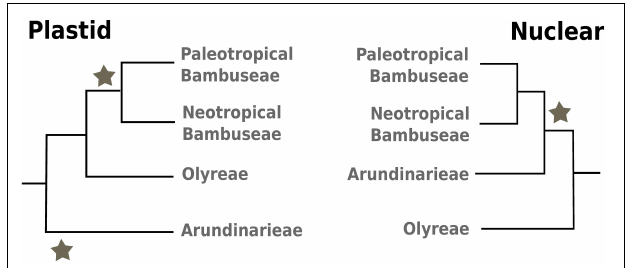
FIGURE 1 | Phylogenetic relationship of the bamboo clades. The figure summarizes established phylogenetic relationships between the herbaceous Olyreae and the three woody clades: Arundinarieae, Paleotropical, and Neotropical Bambuseae. The two panels represent the tree topologies based on plastome (left) or nuclear (right) analyses. The gray stars indicate the woody lineages. They show that nuclear analyses support the monophyly of the woody bamboos (versus their paraphyly in plastome